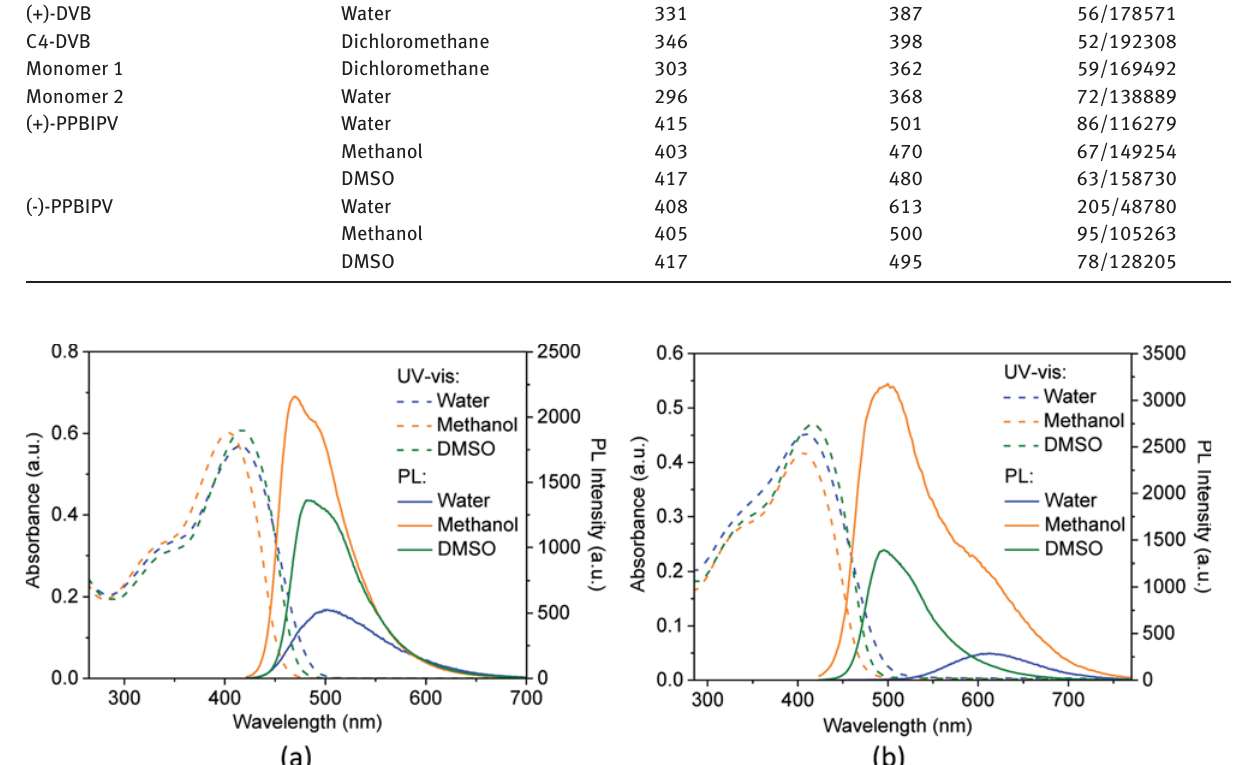
Figure 3: UV-vis and PL spectra of (+)-PPBIPV in water, methanol and DMSO (a); UV-vis and PL spectra of (-)-PPBIPV in water, methanol and DMSO